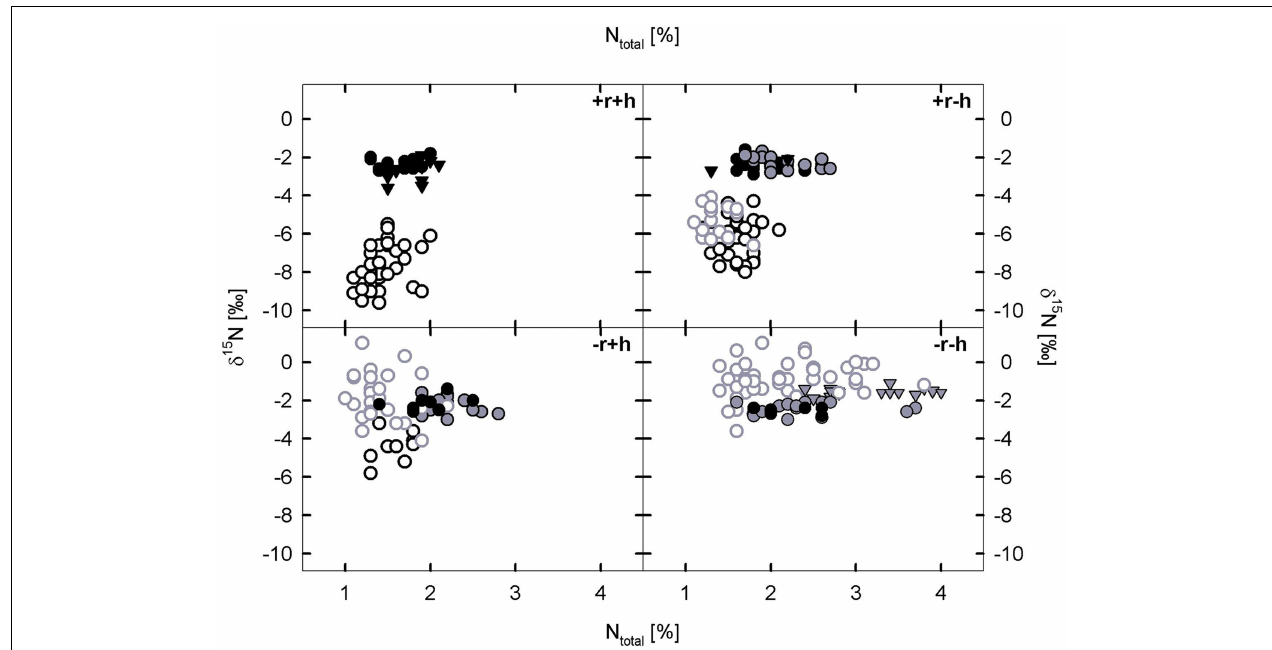
Anthyllis vulneraria ( • ) and Dorycnium germanicum ( (cid:2) ), Helianthemum nummularium (black-open: ◦ ) and gray symbols indicate mesic, non-target species: Lotus corniculatus ( • ), Trifolium pratense ( (cid:2) ) and Galium mollugo (gray-open: ◦ ). Every symbol in this figure represents one replicate per species and restoration treatment, mean values are given in Figure 3 , neighborhood effects of legumes on non-legume species are shown in Figure 4